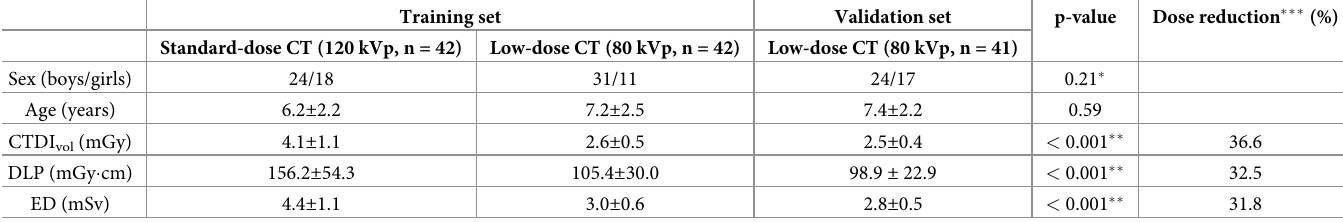
Table 1. Patient characteristics and radiation